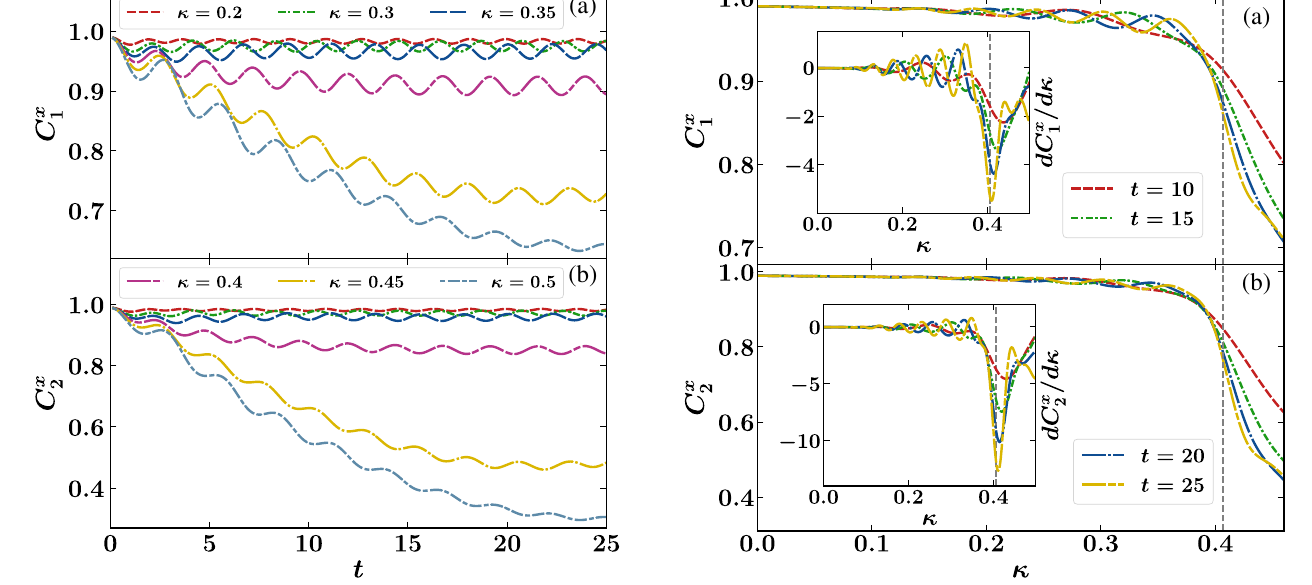
FIG. 3. Ferromagnetic to paramagnetic quantum phase tran- sition in the ANNNI chain as revealed via real-time dynamics of local observables. (a) C x 1 and (b) C x 2 at different times plotted as functions of κ after the quench (the legend is the same for both observables). Insets: derivative with respect to κ of the results shown in the main figure. The initial state is the ground state of the ANNNI Hamiltonian with Γ ¼ 0 . 2 and κ I ¼ 0 . The vertical dashed lines mark the critical κ c ≈ 0 . 41